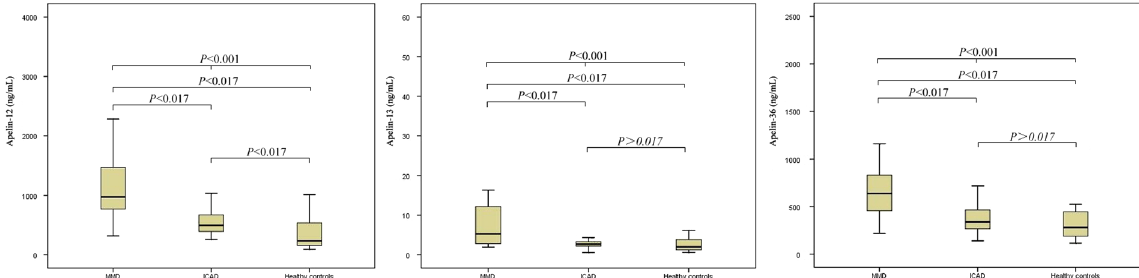
Figure 1. Apelin-12, apelin-13, and apelin-36 levels in patients with moyamoya disease (MMD) or intracranial atherosclerotic disease (ICAD) and in healthy controls.